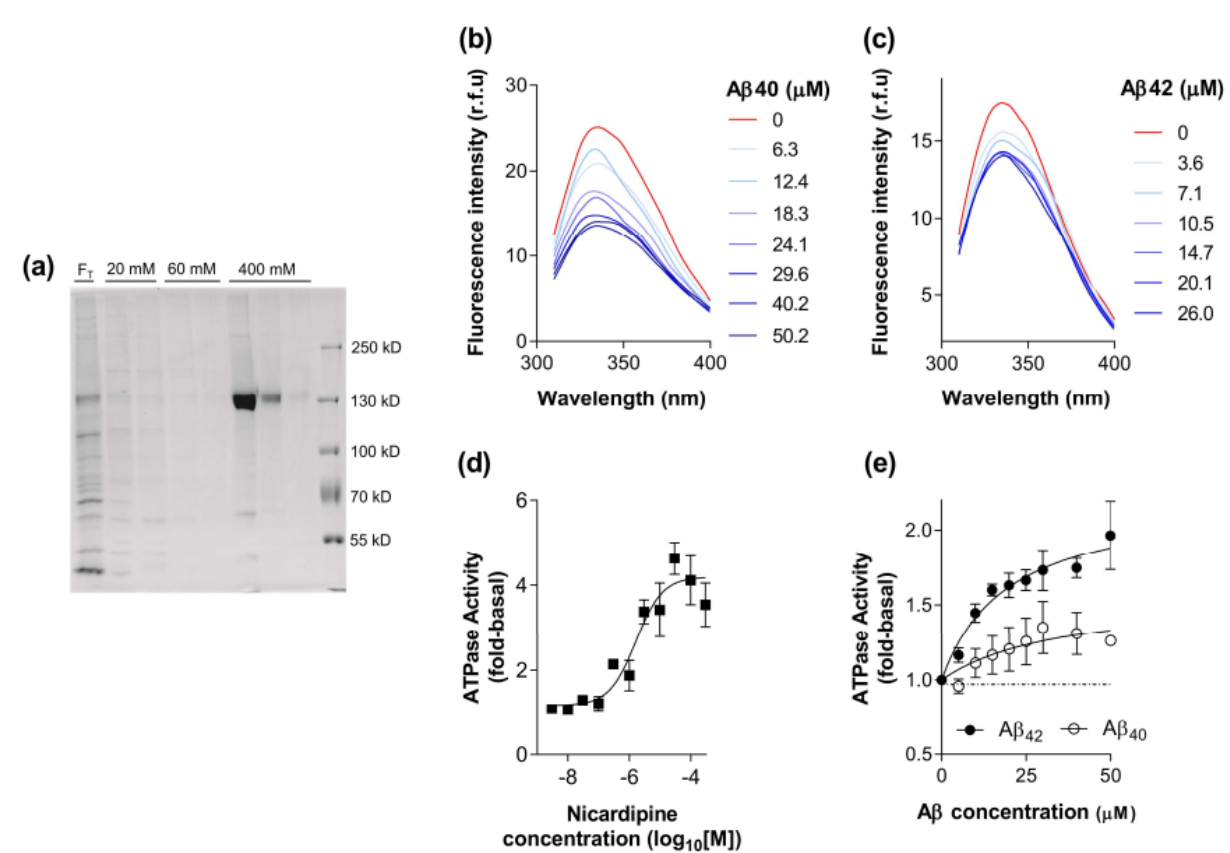
Figure 1. The interaction between A β 40 and A β 42 peptides with purified, reconstituted P-gp. ( a ) Fractions obtained from the metal affinity purification of P-gp were separated on 8% SDS-PAGE and detected with Instant Blue TM protein stain. Fractions (40 µ L) from each stage of the purification were loaded onto the gel. F T corresponds to the unbound detergent extracted material, 20 mM and 60 mM represent washing stages, and 400 mM is the elution phase. ( b ) Representative fluorescence emission spectra were obtained for the endogenous tryptophan residues of purified, reconstituted P-gp (15 µ g) with excitation at 295 ± 10 nm at 37 ◦ C. Spectra were recorded in the absence or presence of a series of A β 40 concentrations. ( c ) Fluorescence emission spectra obtained as in ( b ), but with varying concentrations of A β 42 peptide. ( d ) ATPase activity of purified, reconstituted P-gp (0.2–0.5 µ g) in the presence of varying concentrations of nicardipine. The activity was measured over 40 min at 37 ◦ C and normalised to the value obtained in the absence of drug (basal). Data were fitted by the general dose-response relationship using non-linear least squares regression and values represent mean ± SEM obtained from four independent preparations. ( e ) ATPase activity of purified, reconstituted P-gp (0.2–0.5 µ g) in the presence of varying concentrations of A β 40 and A β 42 peptide. The activity was measured over 40 min at 37 ◦ C and normalised to the value obtained in the absence of drug (basal). Data were fitted by a hyperbolic relationship using non-linear least squares regression and values represent mean ± SEM obtained from three independent